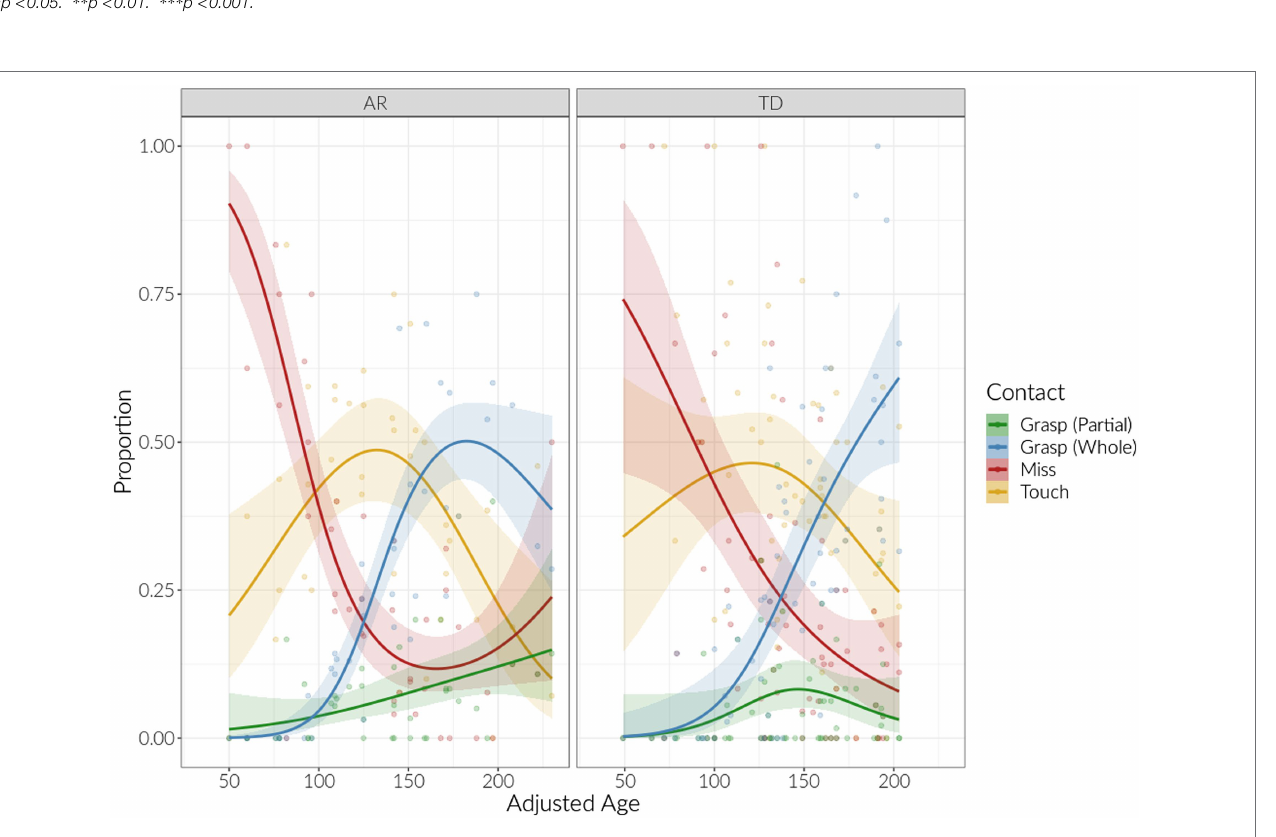
FIGURE 4 | Proportion of reaching outcomes by age (adjusted for prematurity as appropriate) and group (AR = at risk, TD = typical development). Displayed are individual points and quasibinomial-smoothed line, with 95% confidence